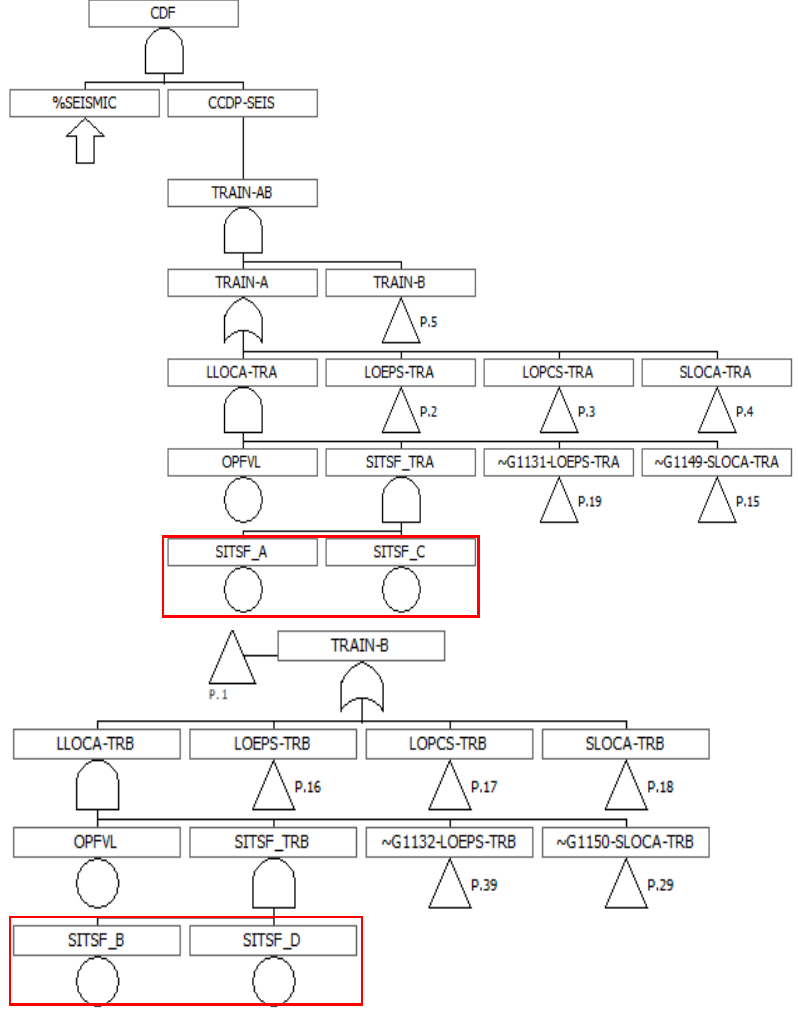
Figure 8. SUCDF fault tree (Model A).